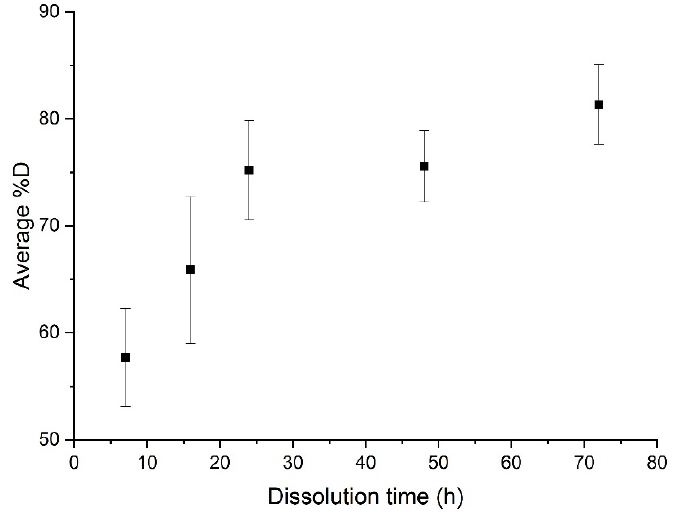
Figure 4. Evolution of the average % D as a function of dissolution time for a simple dissolution of a “composite:acetone” ratio of 1:4.